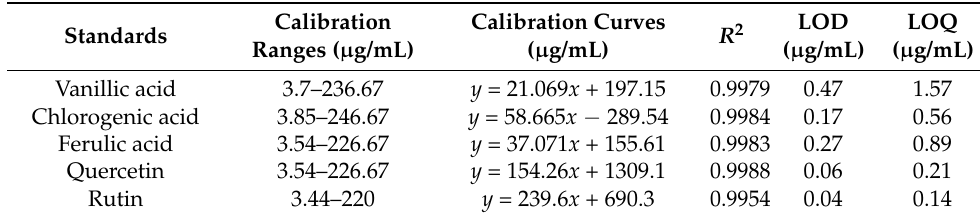
Table 5. Standard analytes used for elaborating the calibration curves with the range used, equations, R 2 , LOD, and LOQ of each